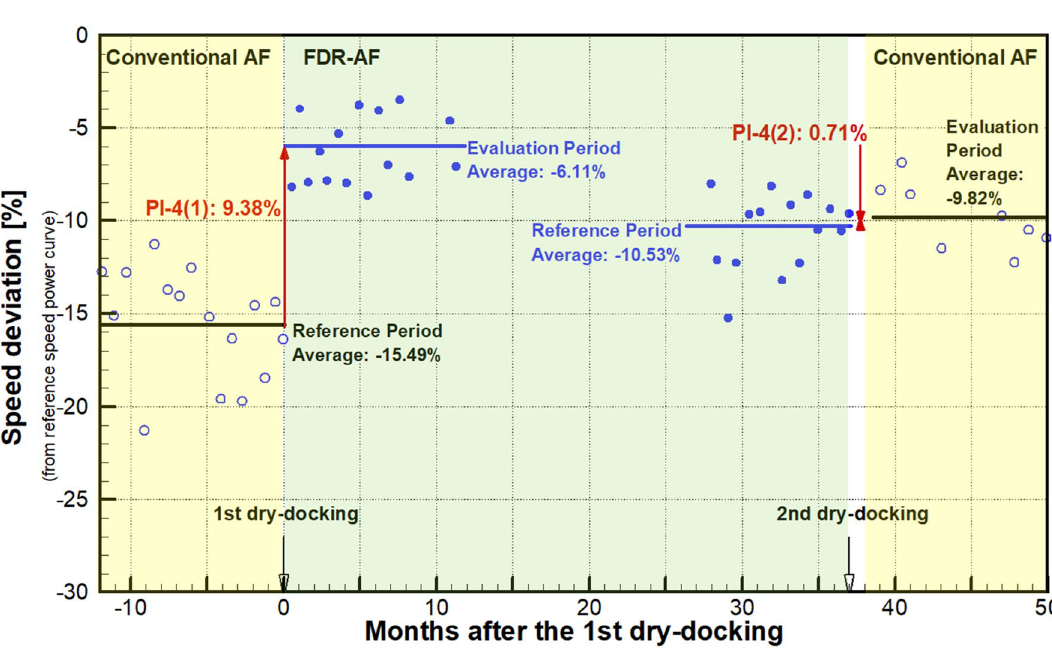
Figure 9. The maintenance effect